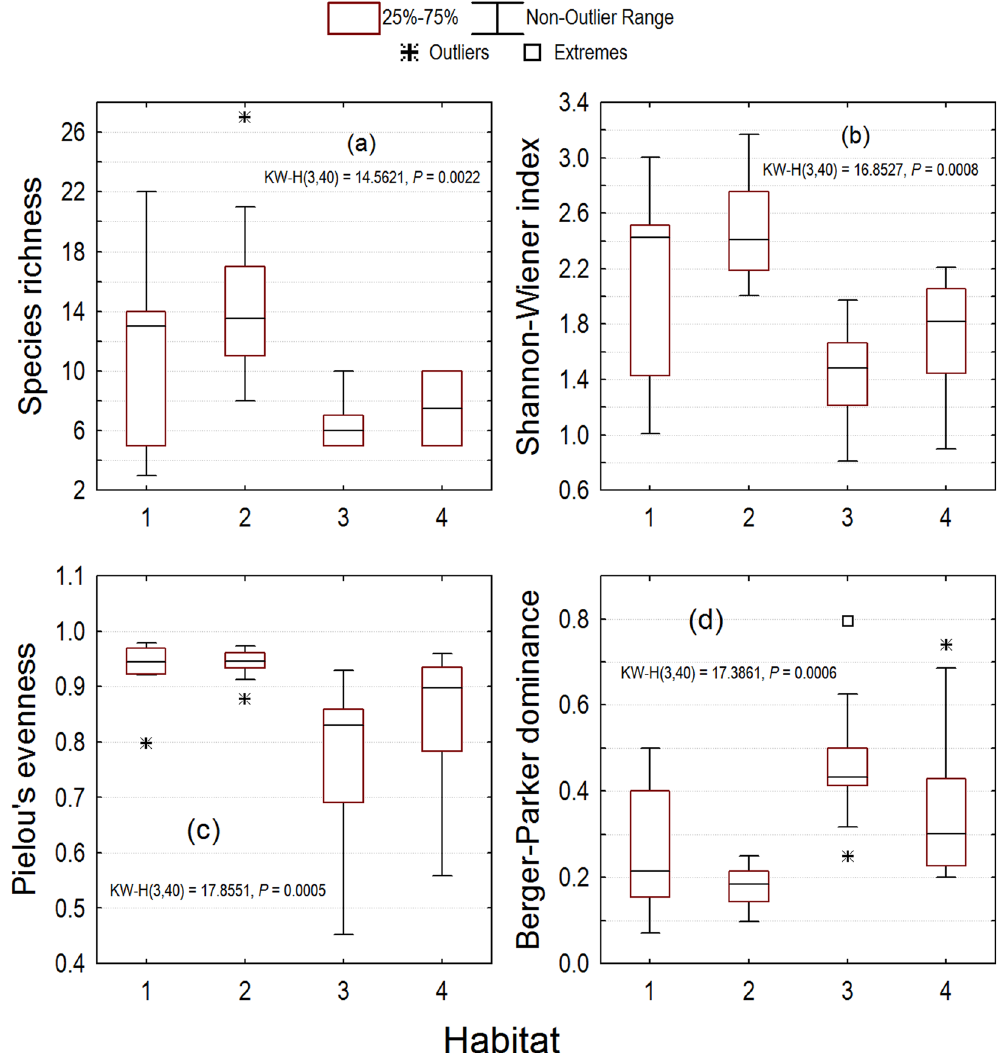
Figure 6. Plot-scale species richness and diversity across habitats in a karst tiankeng landscape. Habitat code: 1 = Chuandong Tiankeng; 2 = Shenmu Tiankeng; 3 = Forest Remnants; 4 = Fengshui